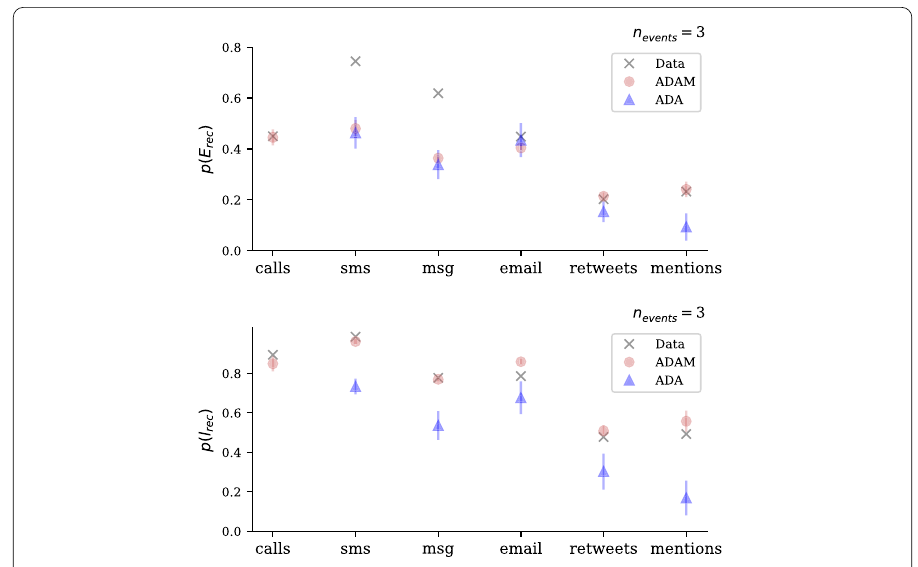
Figure 4 Memory drives temporal reciprocity in activity-driven network model. Fraction of reciprocations p ( E rec ) (top), and fraction of links having at least one reciprocation, p ( l rec ) (bottom), for several empirical communication channels (Data), as well as in synthetic temporal networks fitted by the ADAM and ADA models. The ADAM model, implementing both memory and attractiveness of nodes, reproduces empirical levels of temporal reciprocity in all datasets, outperforming the memoryless ADA model. We filter out links with less than n events = 3 events. For calls, ADA does not produce any links with more than 3 events on them, so all edges are filtered out and the ADA symbol disappears. Qualitatively similar results are obtained for a different choice of filter, n events = 5 (see Additional file 1 Section